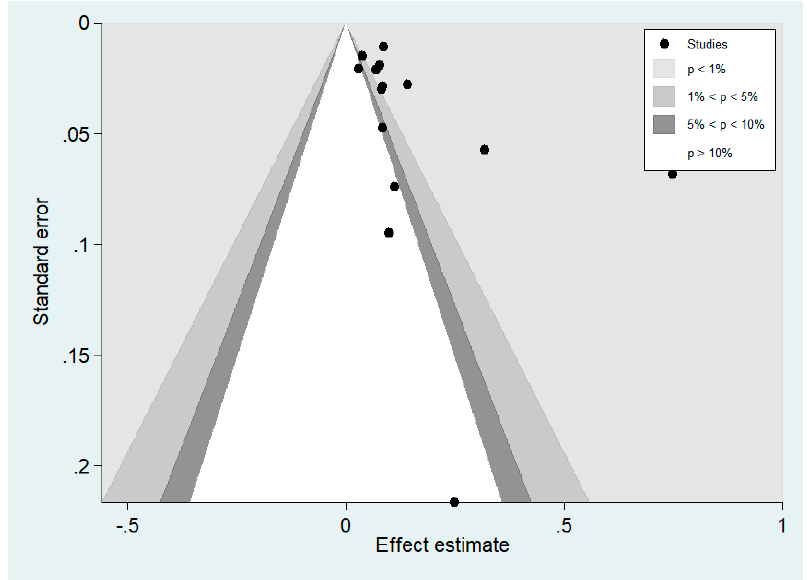
Figure 9. Contour-enhanced funnel